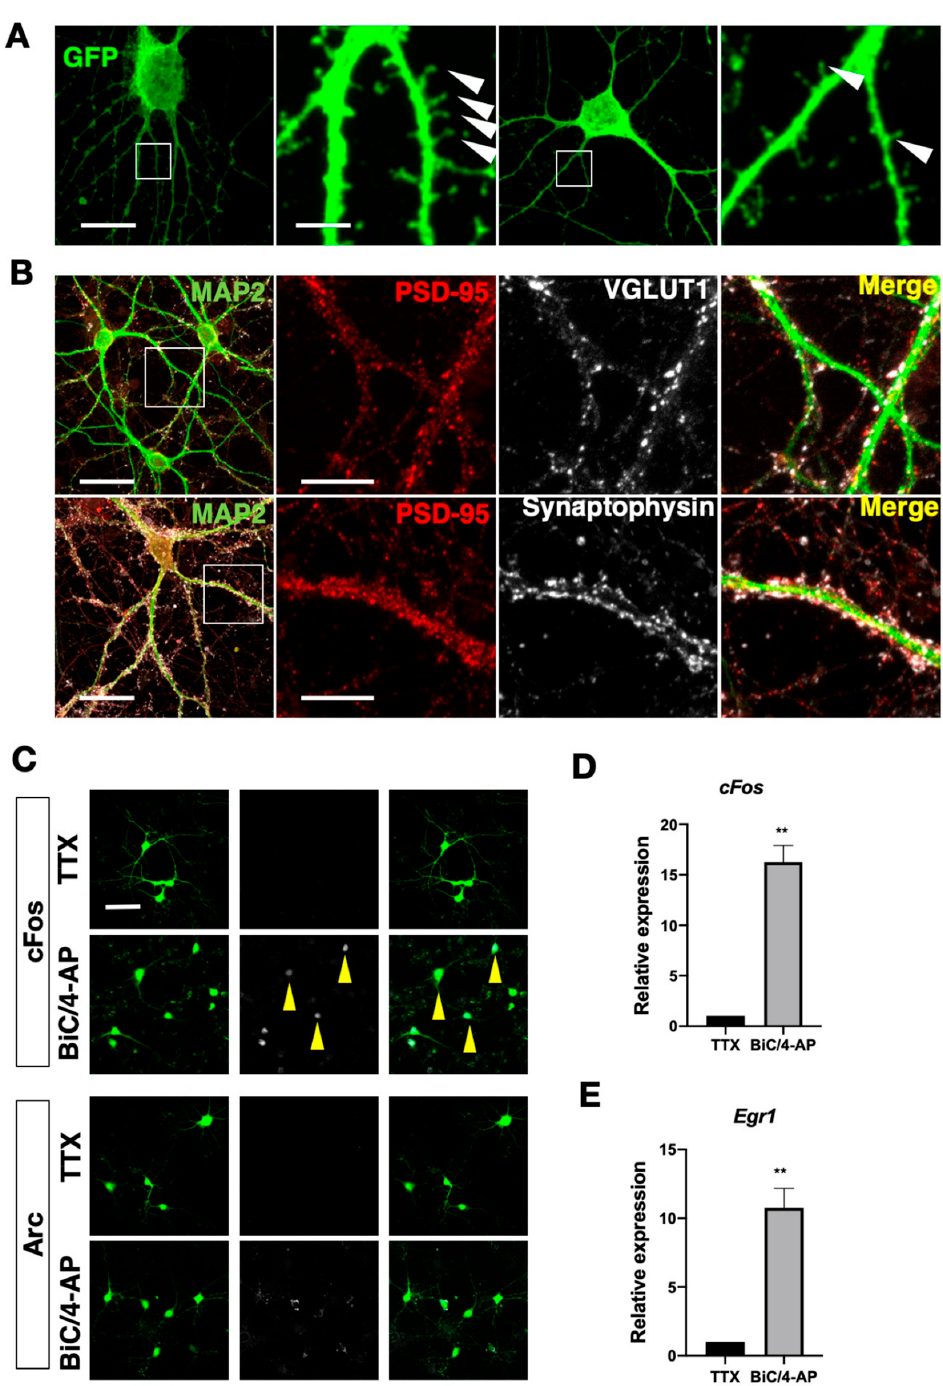
Figure 2. Cellular functionality and synaptic maturation of NPC-iNs. ( A ) EGFP + NPC-iNs at 7 DAI (green). White square box indicates area magnified on right side, and arrowheads highlight dendritic spines. Scale bar = 25 µm (left images) and 5 µm (magnified images). ( B ) Confocal images of NPC-iNs (green) at 22 DAI (top) and 25 DAI (bottom) stained with postsynaptic marker presynaptic marker PSD95 (red), presynaptic markers synaptophysin (bottom), and VGLUT1 (top). White boxes indicate area magnified on the right side, scale bar = 28 µm (left images) and 10 µm (magnified images). ( C ) EGFP + NPC-iNs at 13 DAI exposed to pharmacological agents Tetrodotoxin (TTX) or Bicuculline (BIC) and 4-Aminopyridine (4-AP), stained for immediate early genes cFos or Arc (white). Arrows highlight NPC-iNs expressing cFos or Arc. Scale bar = 100 µm. ( D , E ) cFos and Egr1 mRNA expression levels after being exposed to TTX or BiC/4-AP. (Data for N = 3, ** p < 0.005, two-tailed one-sample t -test). Data are presented as mean ± s.d.